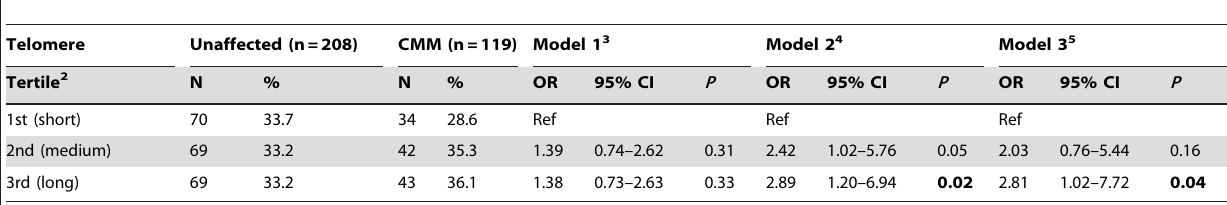
Table 3. Association of telomere length with melanoma in 53 melanoma-prone families 1 .